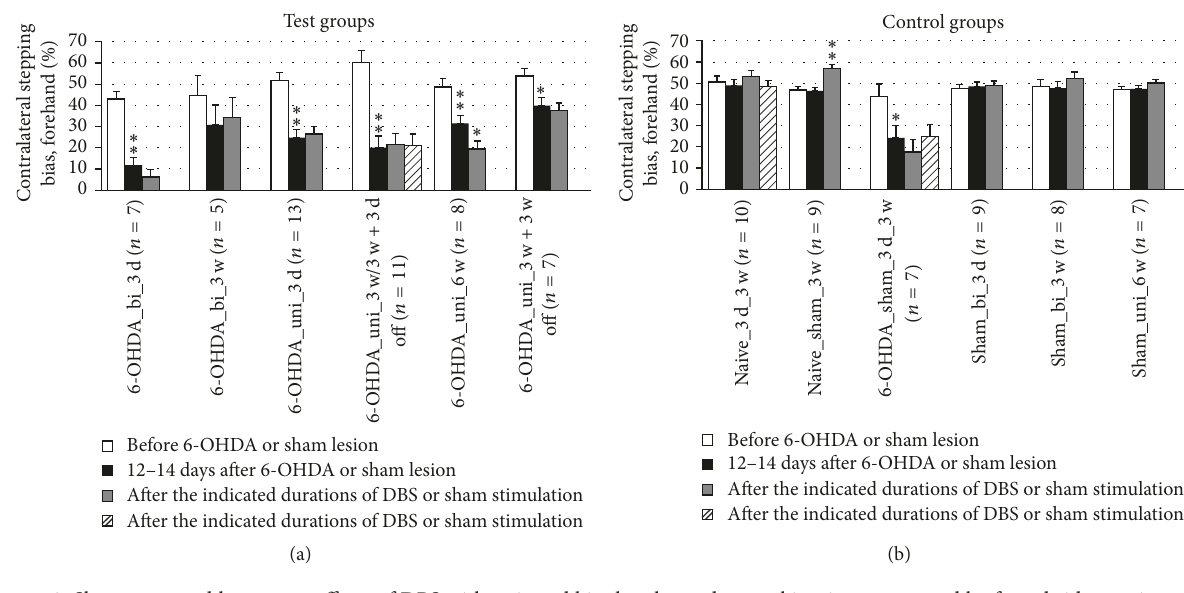
Figure 8: Short-term and long-term effects of DBS with uni- and bipolar electrodes on akinesia as measured by forced sidestepping of the forepaws in the forehand direction in the stepping tests. (a) and (b) refer to test groups and controls, respectively. Different column patterns indicate different times of behavioral testing; white: before 6-OHDA or sham lesion; black: 12–14 days after 6-OHDA or sham lesion; gray and hatched: after the durations of DBS or sham stimulation indicated in the group labels. For experimental details see Table 1. Significance levels are indicated with asterisks as follows: ∗∗ 𝑝 ≤ 0.01 , ∗ 𝑝 ≤ 0.05 , b (borderline): 0.05 < 𝑝 ≤ 0.08 according to one-way ANOVA. Asterisks above black columns refer to white columns; all others refer to black columns.